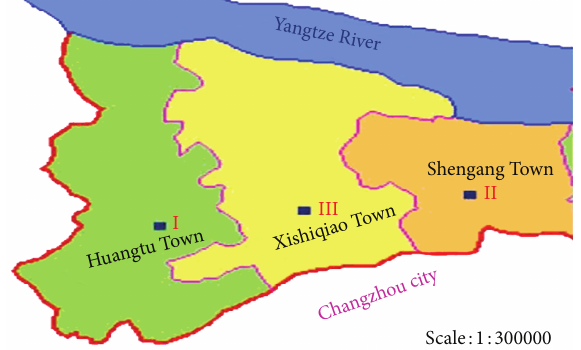
Figure 1: The distribution map of typical agriculture areas in Jiangyin City (I is grape orchard, II is vegetable base, and III is conventional planted